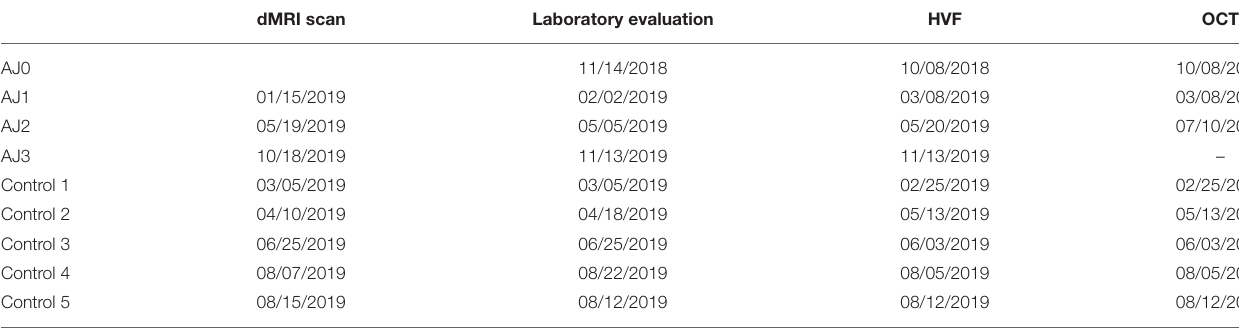
TABLE 1 | Study timeline for dMRI, laboratory evaluation and ophthalmologic exam.